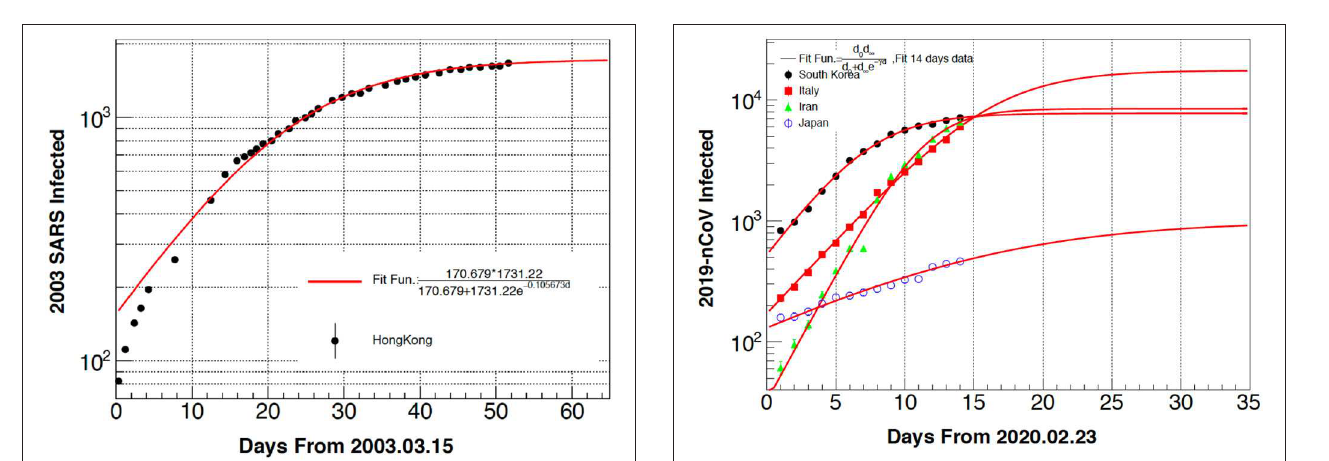
FIGURE 1 | Number of people who tested positive to the SARS virus with function of time starting from March 15, 2003. The theory is given by the full line and the values of the fitting parameters are reported in the inset.